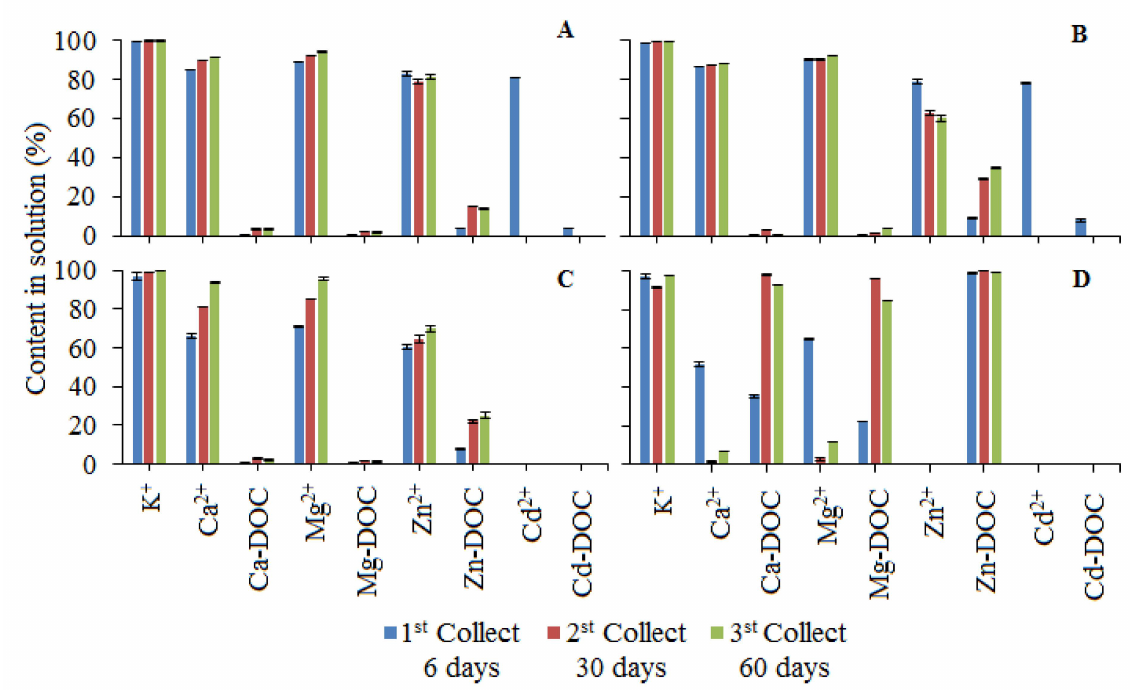
Figure 1. Distribution of the main cationic species and compounds obtained in the soil solution collected in the CT ( A ), CaCO 3 ( B ), GR ( C ) and PCM ( D ) treatments during 60 days of jack bean cultivation. CT = Control, GR = Coffee grounds biochar, and PCM = Coffee parchment biochar. Error bars indicate de standard deviation (n = 4).